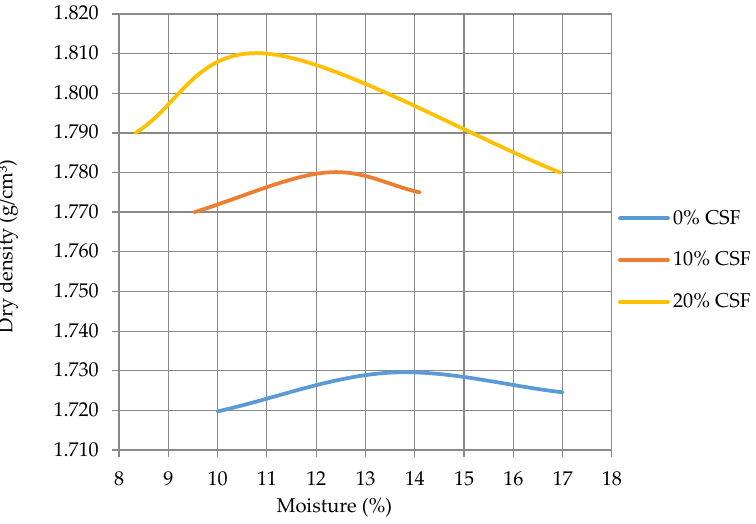
Figure 17. Dry density versus moisture content for soil stabilized with various CSF additions. Table 7. Soil stabilization test results.